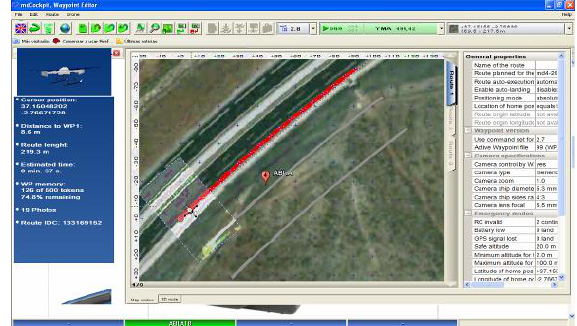
Figure 5. Flight planning make up three parallel